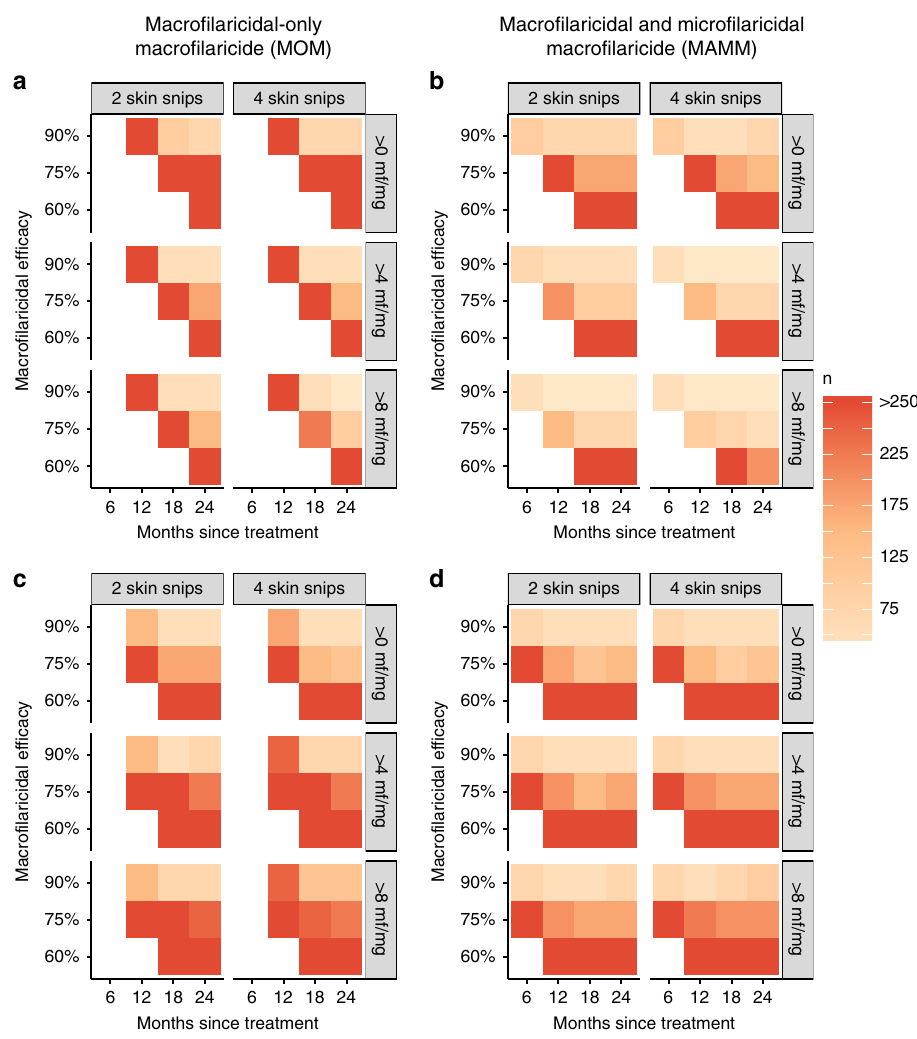
Fig. 5 Sample sizes required to detect a superior response in macro fi laricide-treated compared to ivermectin-treated participants. Each panel depicts sample sizes ( n ) required to detect, with 80% power, a statistically signi fi cant superior response in the macro fi laricide-treated test group compared to